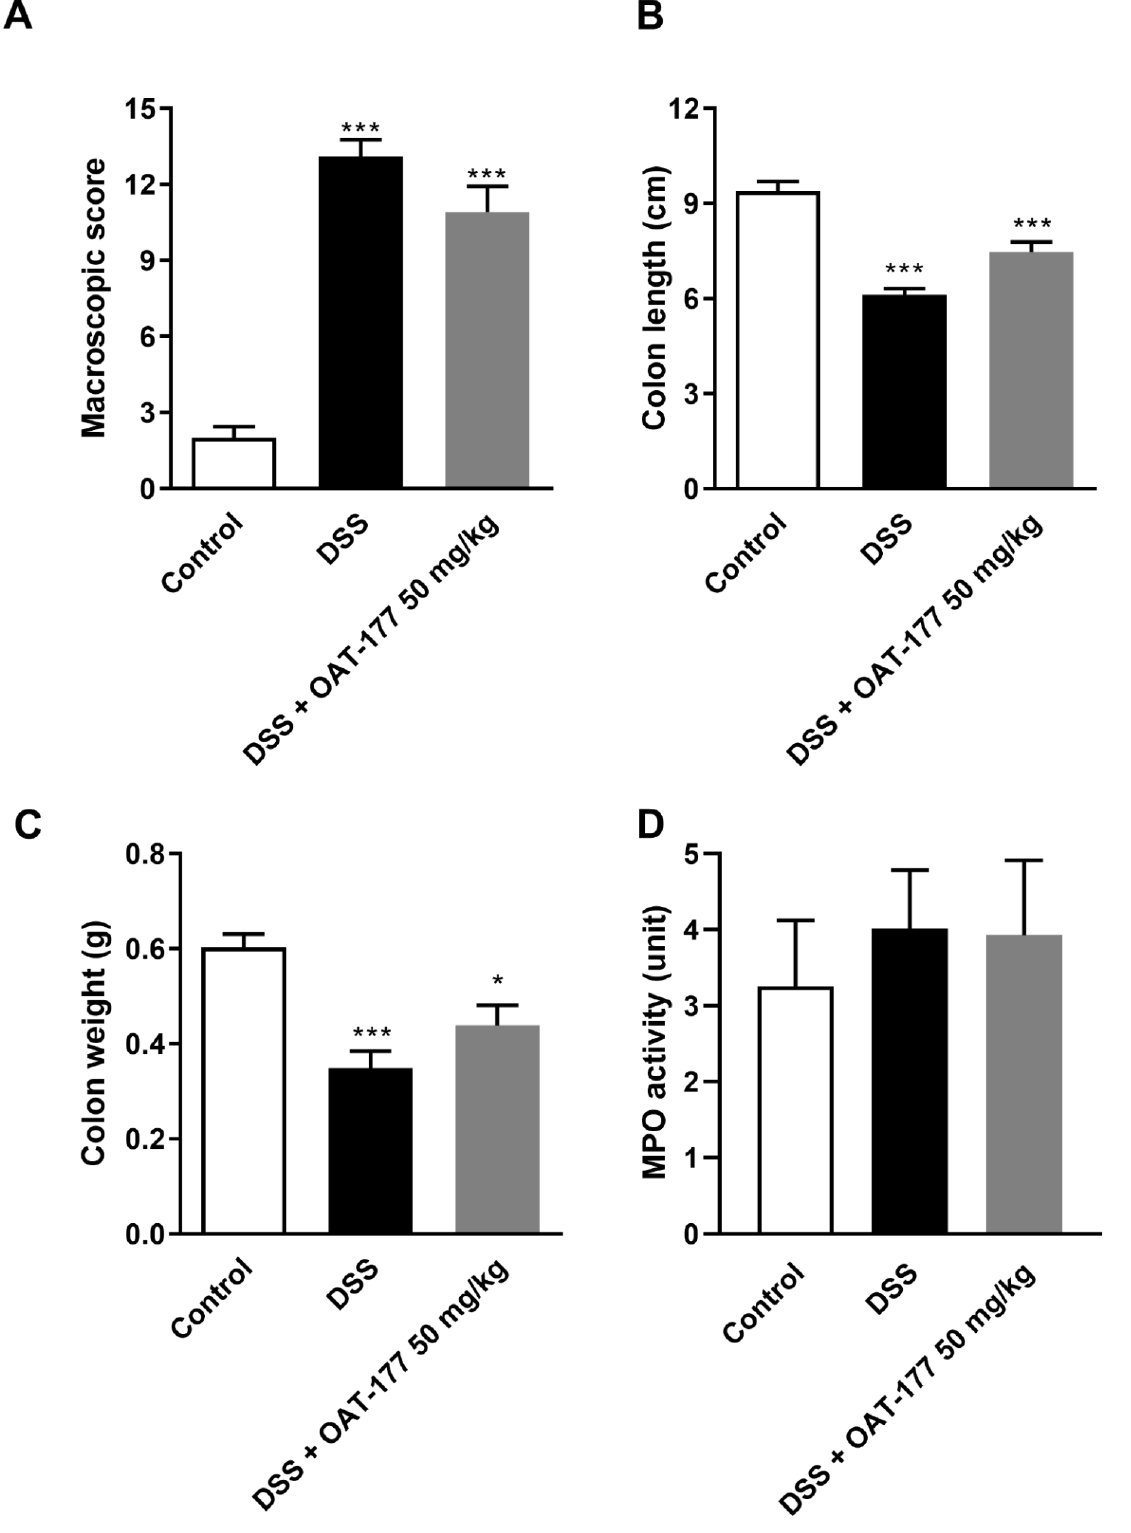
Figure 4. The effect of OAT-177 administered intraperitoneally in the short-term therapeutic protocol on: ( A ) macroscopic score, ( B ) colon length, ( C ) colon weight, and ( D ) myeloperoxidase (MPO) activity in a dextran sulfate sodium (DSS)-induced colitis. Data are expressed as mean ± SEM. Statistical significance from the one-way ANOVA, Tukey’s post hoc test: *** p < 0.001, * p < 0.05 vs. control